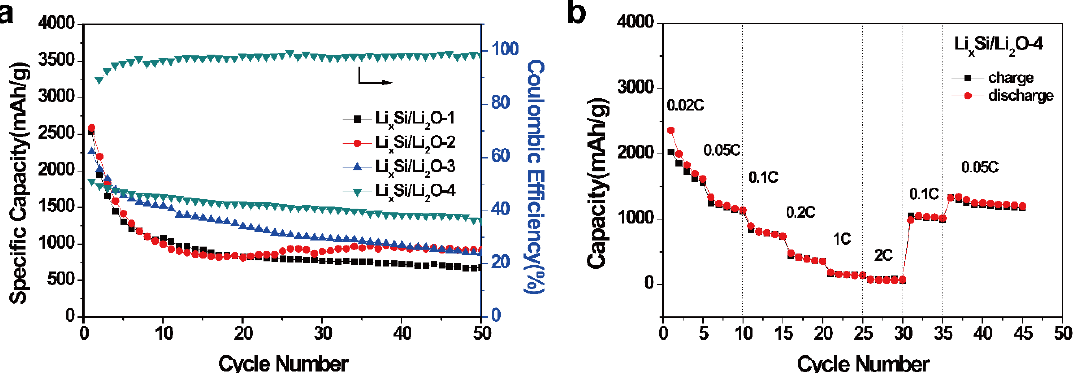
Figure 5. ( a ) Cycling performance of four Li x Si/Li 2 O samples at C/20 (1C = 1.96 A g −1 Li x Si, the capacity is based on the total mass of Li x Si in the electrode). The green line is the Coulombic efficiency of Li x Si/Li 2 O-4 composite; ( b ) Rate stability of Li x Si/Li 2 O-4